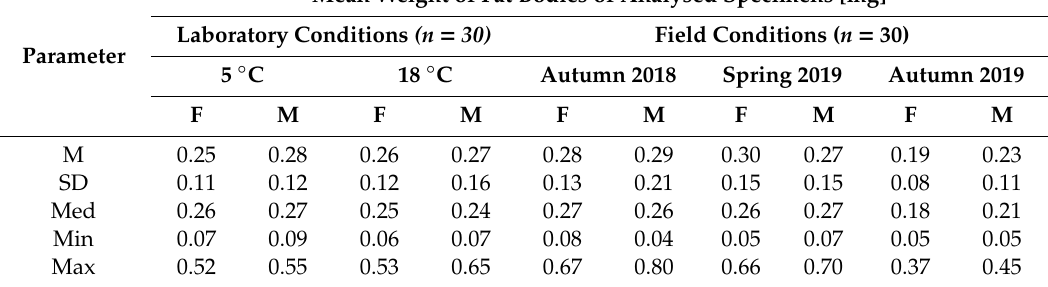
Table 4. Mean weight of fat bodies of adult Dermacentor reticulatus ticks in each group of females and